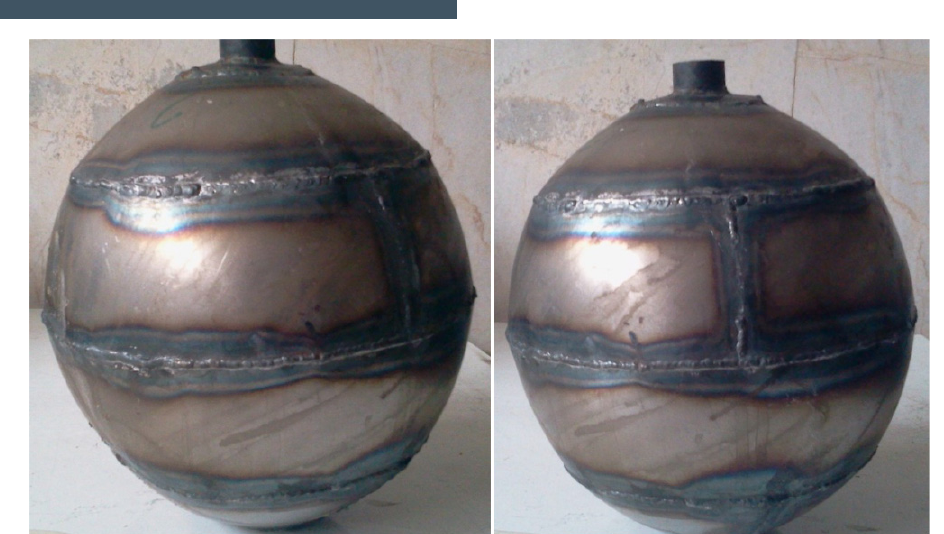
Figure 11. Test samples subsequent to explosion: (left) D = 300 mm, t = 0.75 mm; (right) D = 200 mm, t = 2 mm.